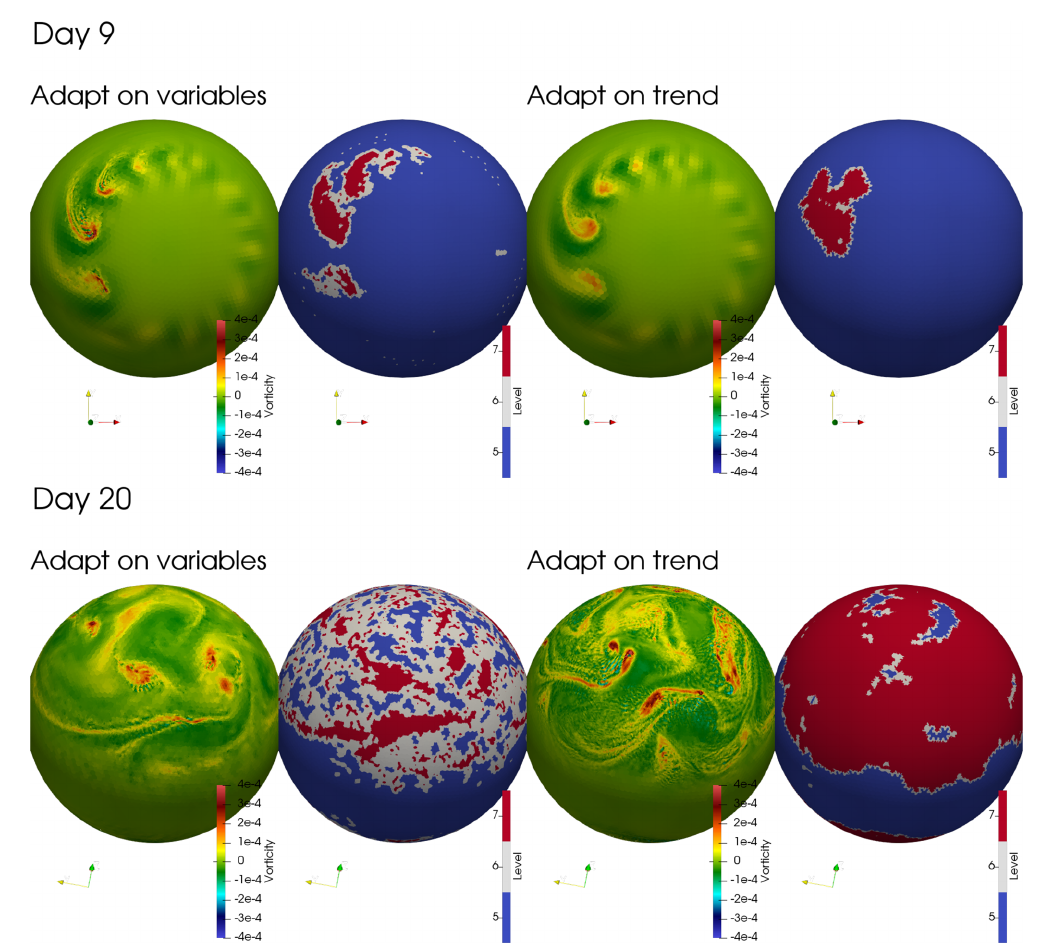
Figure 10. Comparison at days 9 and 20 of the grid compression ratios for the baroclinic instability when adapting on the trend or adapting on the solution. The relative error threshold was set to ε = 0 . 04 (fixed) when adapting on the solution and ε = 2 . 6 when adapting on the trend. In both cases, the resolution is j = 5 , 6 , 7 and there is no additional diffusion. The tolerances were set to achieve similar compression ratios at 9 days. The vorticity field is shown at hybrid vertical level 4 (about